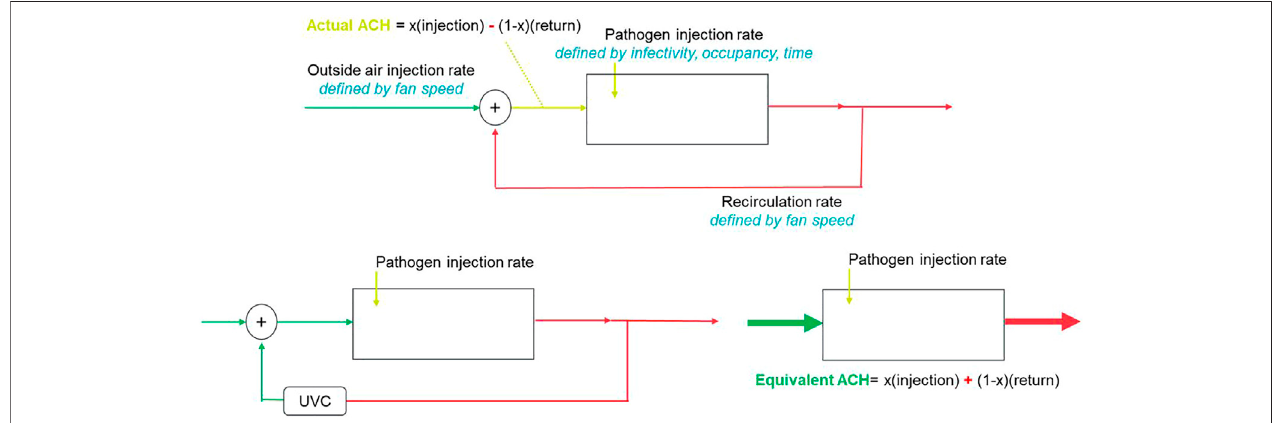
FIGURE 1 | Equivalent ACH (eACH) as it relates to fresh-air injection